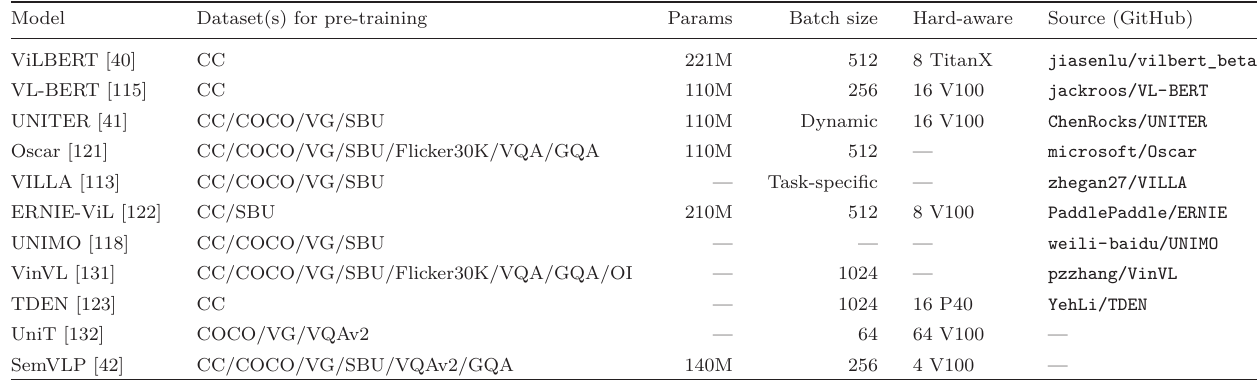
Table 5 Model setting in various papers. COCO refers to MS COCO [129], CC to Conceptual Captions [125], VG to Visual Genome [127], SBU to SBU captions [126], and OI to OpenImages [130] Model